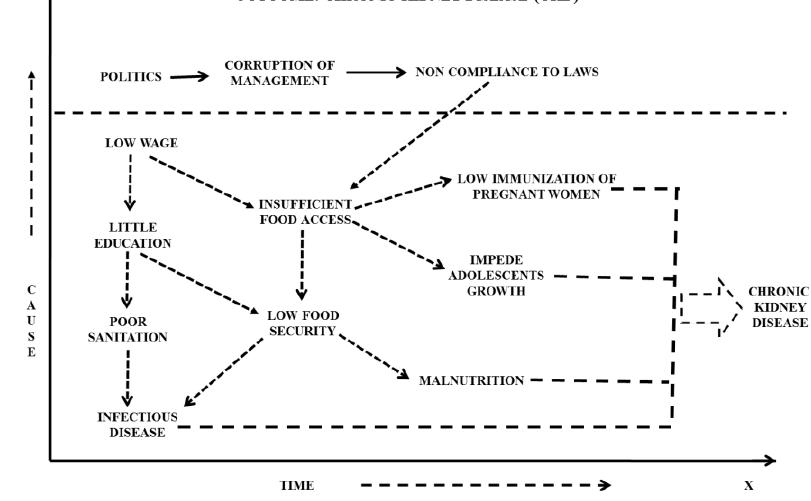
Figure 5. Diagrammatic representation of a causal conceptual model in the Indian scenario. An